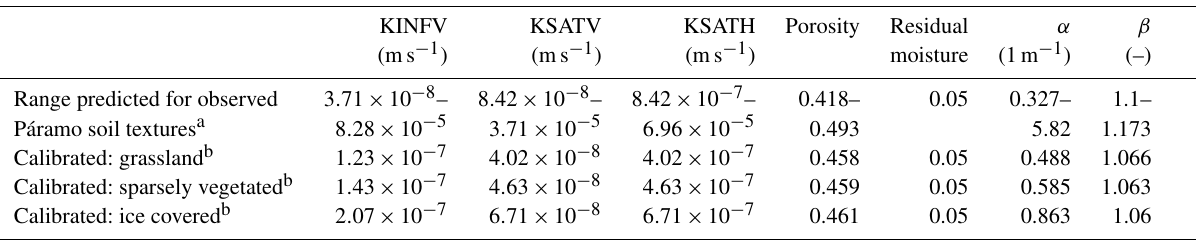
a Predicted using pedotransfer functions with nine páramo soil texture measurements from Ecuador. Samples are from three locations in a glacierized watershed in Volcán Antisana (Minaya, 2016) and four locations about 20km northwest of Chimborazo (Podwojewski et al., 2002) (see Supplement for more details). b Calibrated to match observed discharge at Gavilan